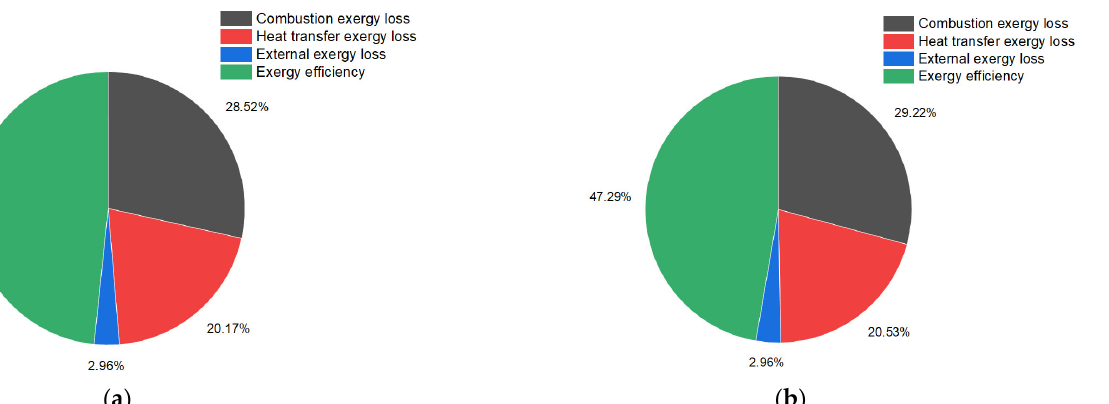
Figure 12. Comparison of exergy loss distribution between the improved scheme and the original scheme. ( a ) The exergy loss distribution of improved scheme. ( b ) The exergy loss distribution of original scheme.